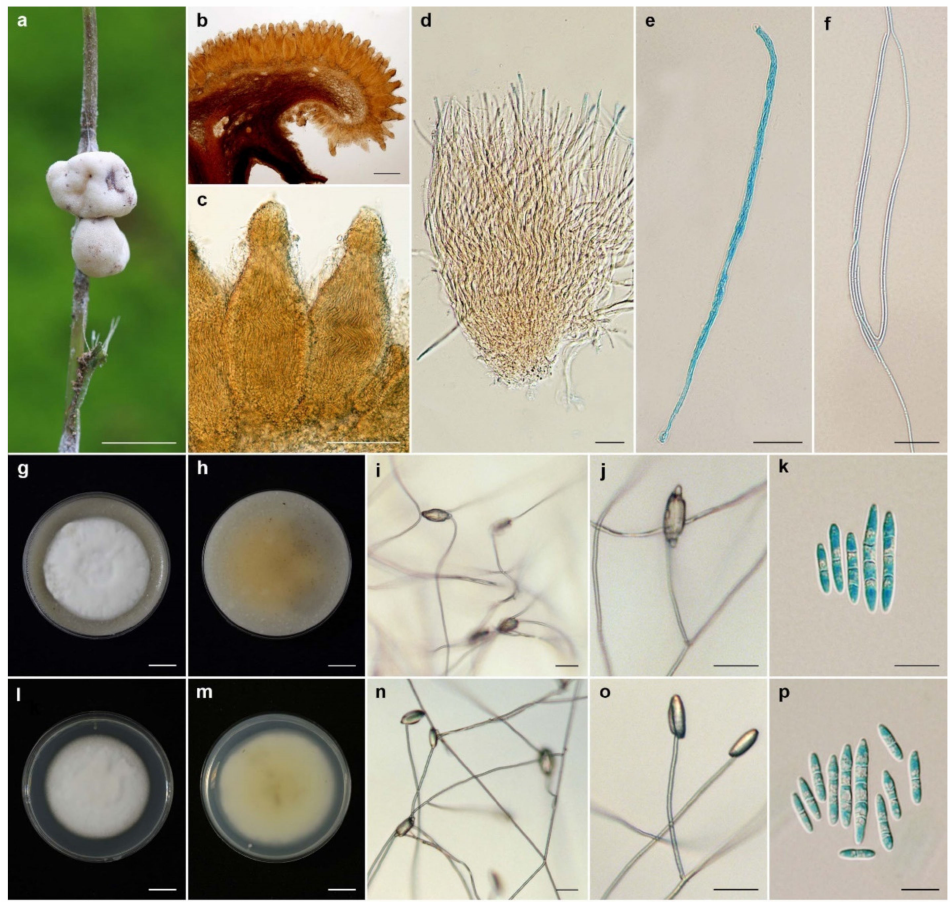
Figure 2. Ascopolyporus albus . ( a ) Stromata on living stem of bamboo ( Bambusae ); ( b ) cross-section through stroma showing perithecia (BBH30734); ( c ) perithecia; ( d , e ) asci. ( f ) ascospores; ( g ) colony obverse on OA; ( h ) colony reverse on OA; ( i , j ) phialide apex with conidial head on OA; ( k ) conidia on OA; ( l ) colony obverse on PDA; ( m ) colony reverse on PDA; ( n , o ) phialide and conidia on PDA; ( p ) conidia on PDA. Scale bars: ( g , h , l , m ) = 10 mm; ( a ) = 5 mm; ( b ) = 200 µ m; ( c ) = 100 µ